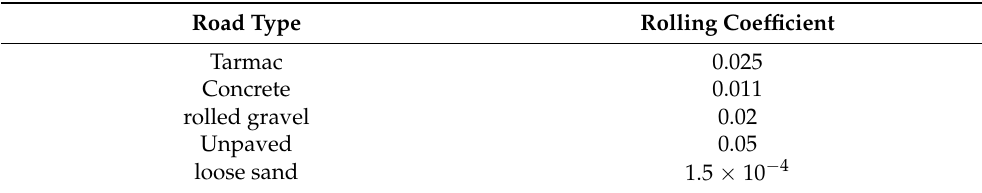
Table 2. Rolling-resistance values for different road